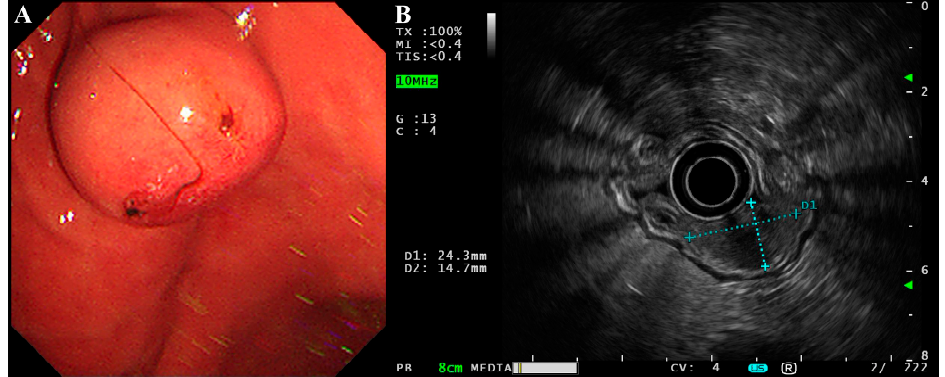
Figure 1. EGD and EUS of the gastroblastoma. ( A ) EGD showed a submucosal mass with a small ulcer on its surface at the lesser curvature of the gastric body. ( B ) EUS showed the lesion was hy- poechoic with a clear boundary and uniform internal echo. The lesion was approximately 2.43 × 1.47 cm in size and originated from the muscularis propria with an intact serosa layer.